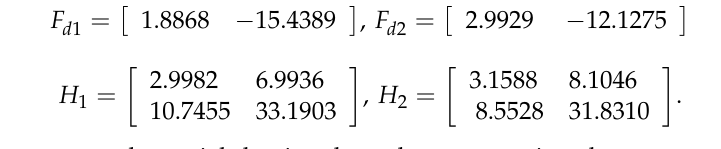
Figure 13. Regions stability for 100 m